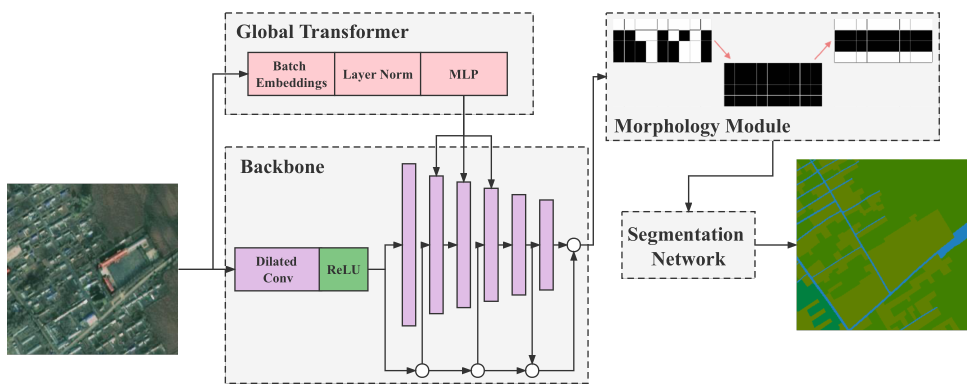
Figure 3. Illustration of our